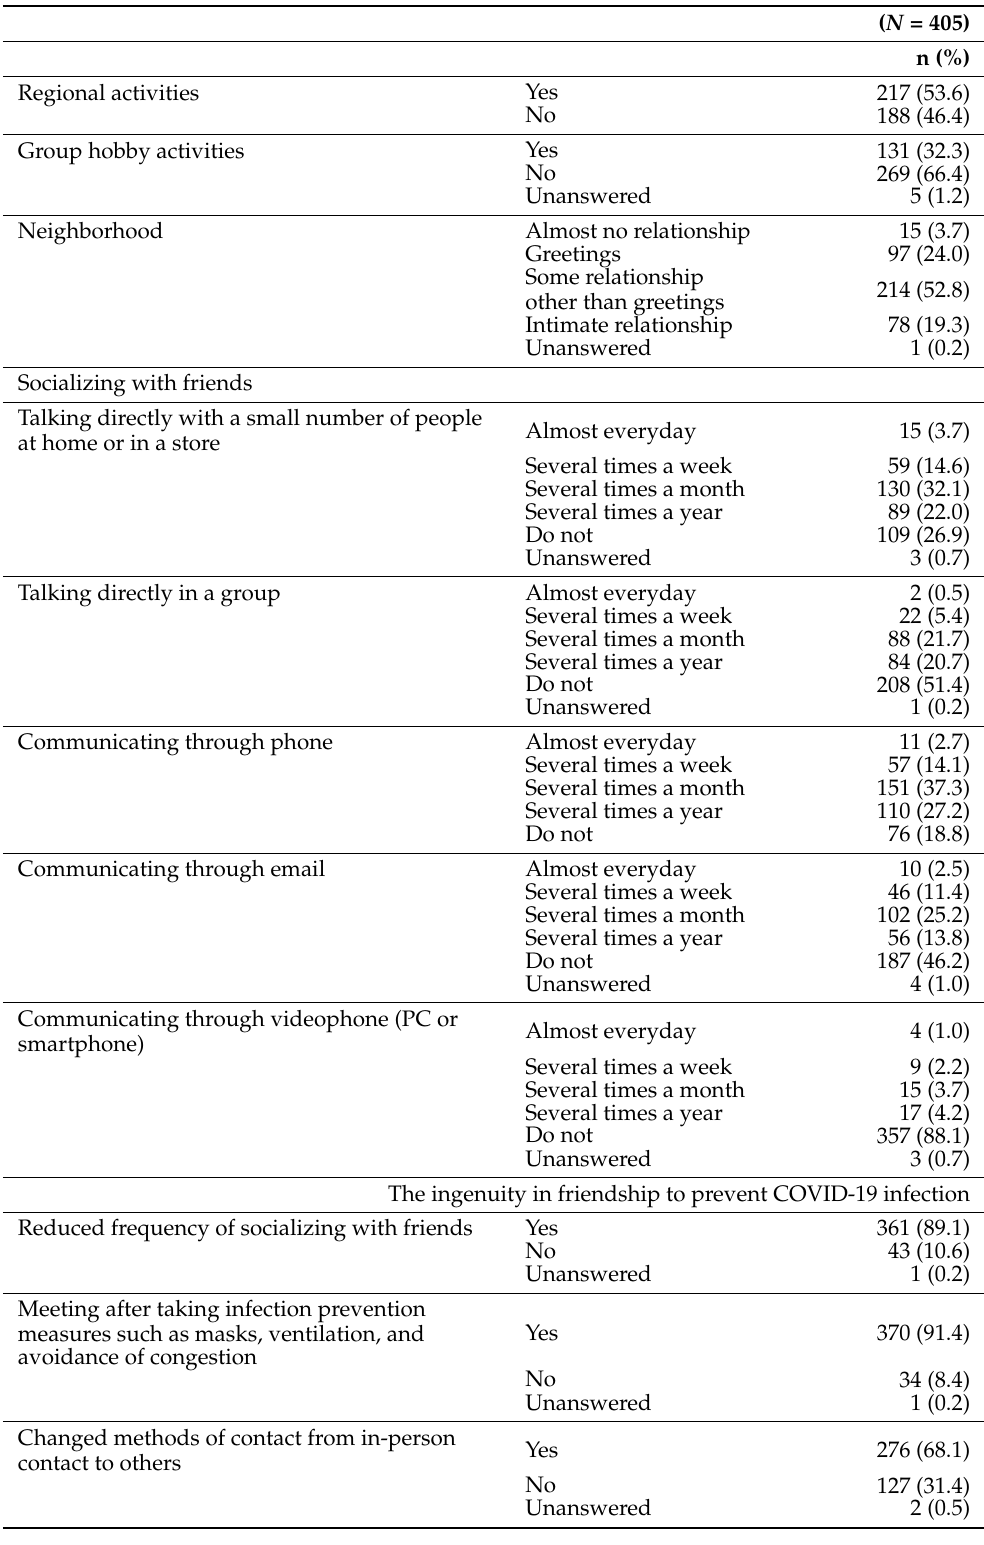
Table 2. Connection with